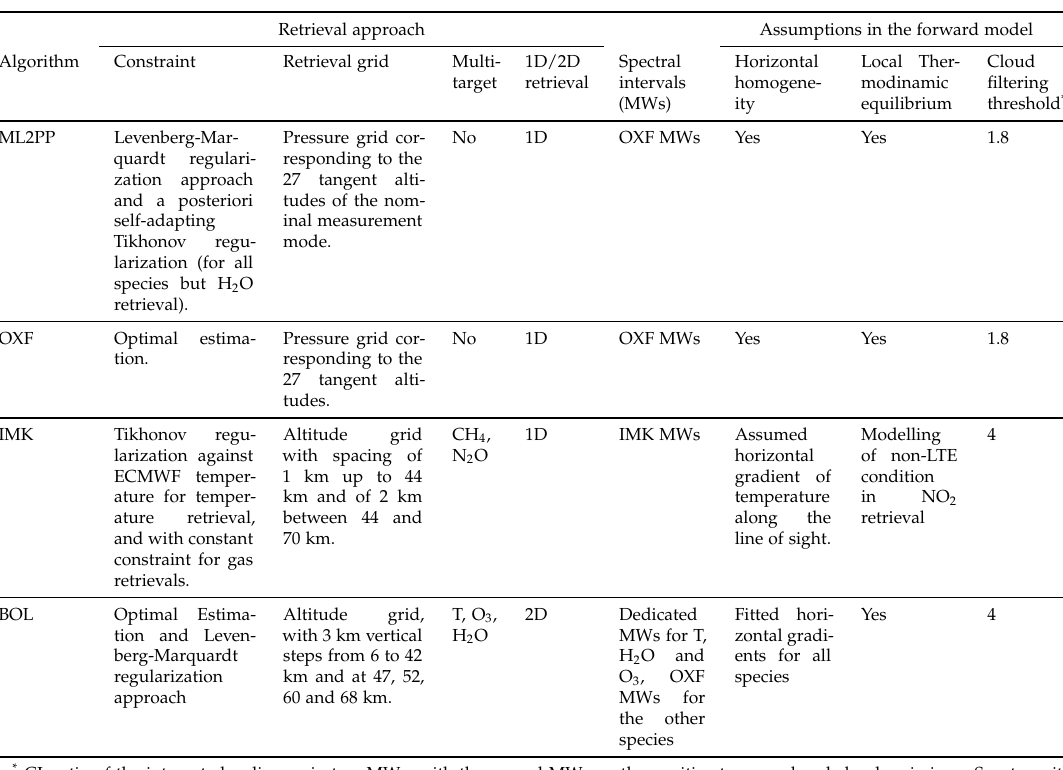
Table 1: Main differences between the four